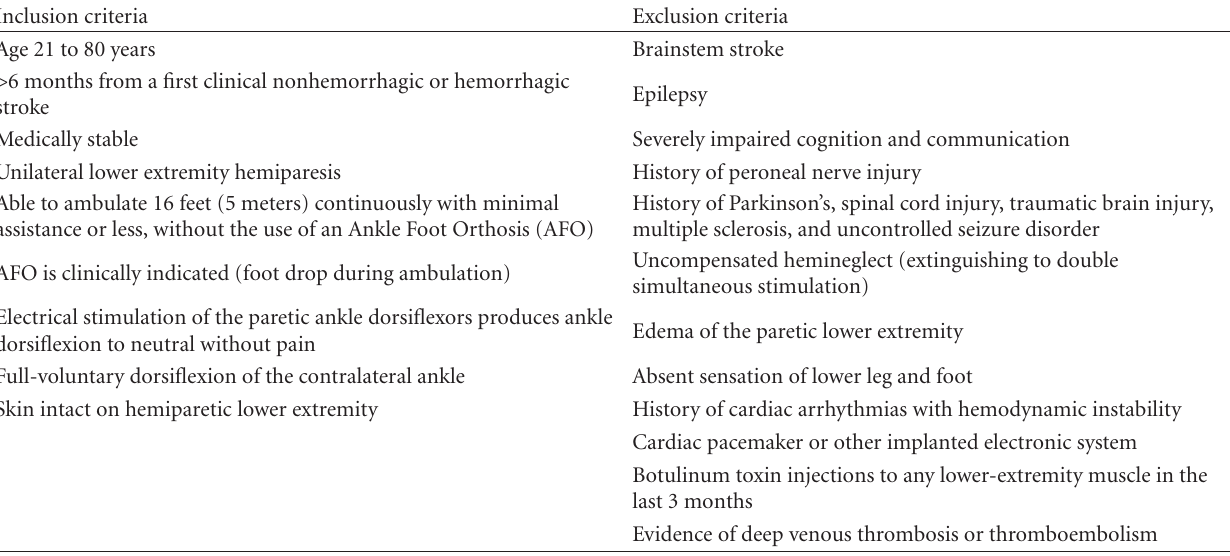
Table 1: Inclusion and exclusion criteria for the stroke